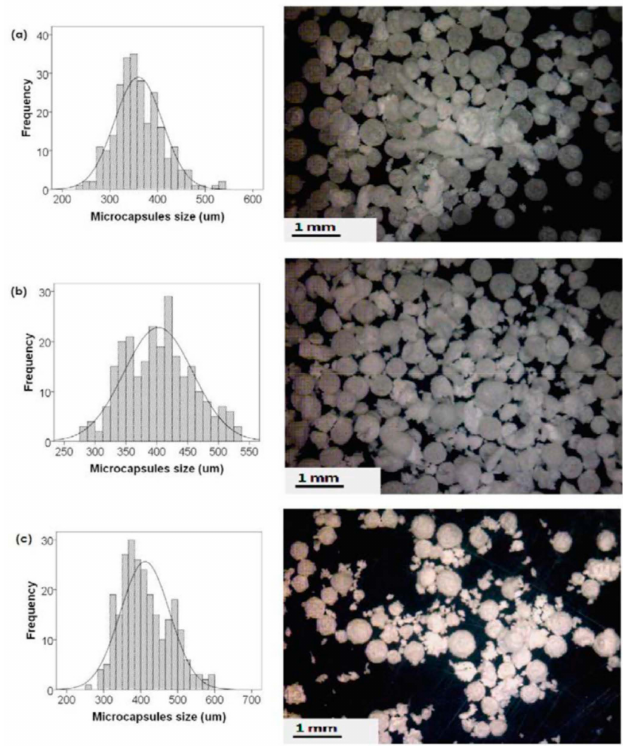
Figure 1. Size distribution (left) and digital microscopic images of alkyd resin encapsulated poly(urea-formaldehyde) (PUF) microcapsules (right), prepared at di ff erent agitation rates, ( a ) 500 rpm, ( b ) 400 rpm, and ( c ) 300 rpm. Adapted from [22], with permission from © 2016 Elsevier.